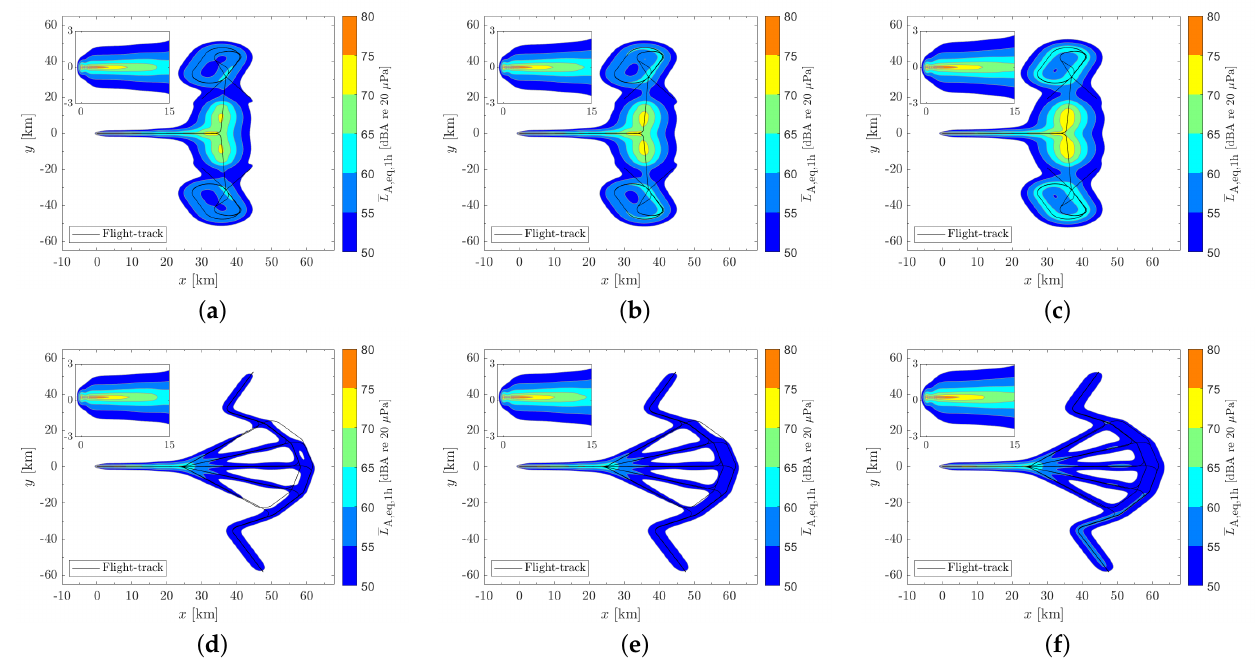
Figure 7. L A,eq,1h noise contours for the vertical holding stack (upper row) and the linear hold point merge (lower row): ( a , d ) Scenario A, ( b , e ) Scenario B, ( c , f ) Scenario C. Inset figures show the noise contours close to the runway. For the sake of clarity, only flight trajectories calculated based on the performance of the Airbus A320 are